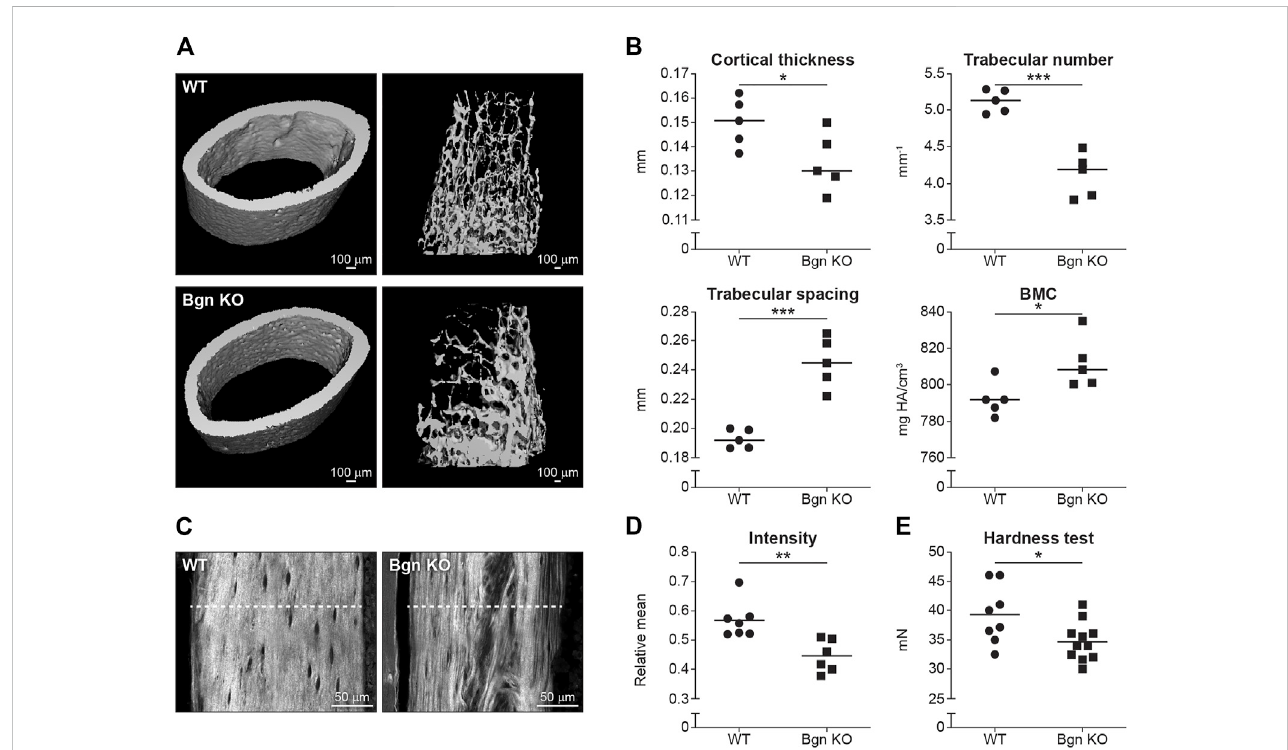
FIGURE 2 Bgn is needed for the structural integrity and the strength of bone. (A) 3D µCT reconstruction of femoral mid-diaphyseal cortical bone and the distal femoral metaphyseal bone from WT and Bgn KO mice (6 week-old), representative images. (B) Quantitative µCT analysis of cortical thickness, trabecular number, trabecularspacing,andBoneMineralContent(BMC)( n =5pergroup). (C) Secondharmonicgeneration(SHG)representativeimagesofthecollagen fi bersinWTand Bgn KOfemurs(6 week-old). (D) QuantitativeSHGanalysisofTypeIcollagenintensity.( n =6/7pergroup). (E) Microindentationanalysis of hardness of the femurs of WT and Bgn KO 6 week-old mice. ( n = 8/11 per